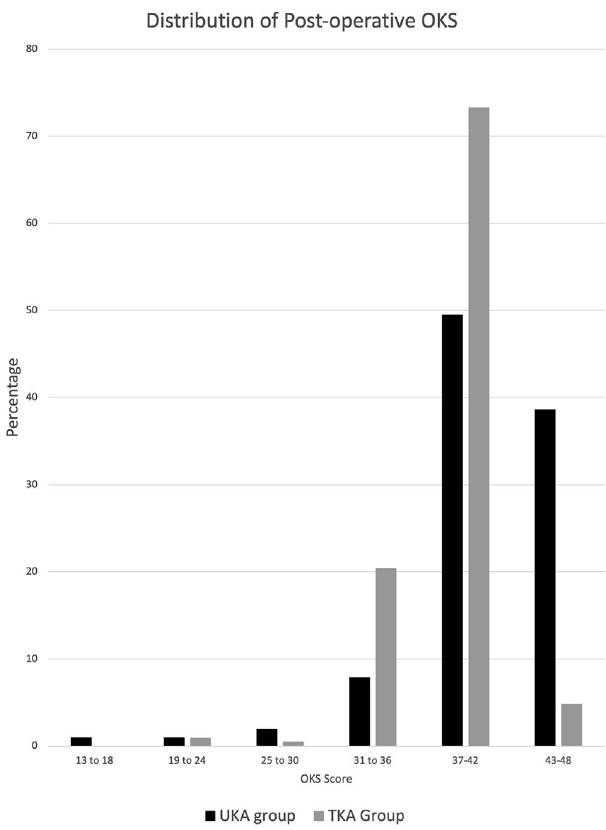
Figure 5. Histogram depicting the distribution of the post-operative Oxford Knee Score of both the